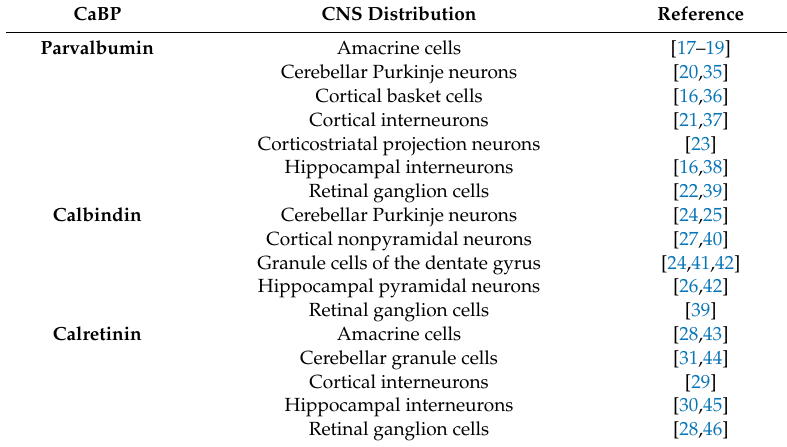
Table 1. Summary of selected CNS neuronal populations and their CaBP